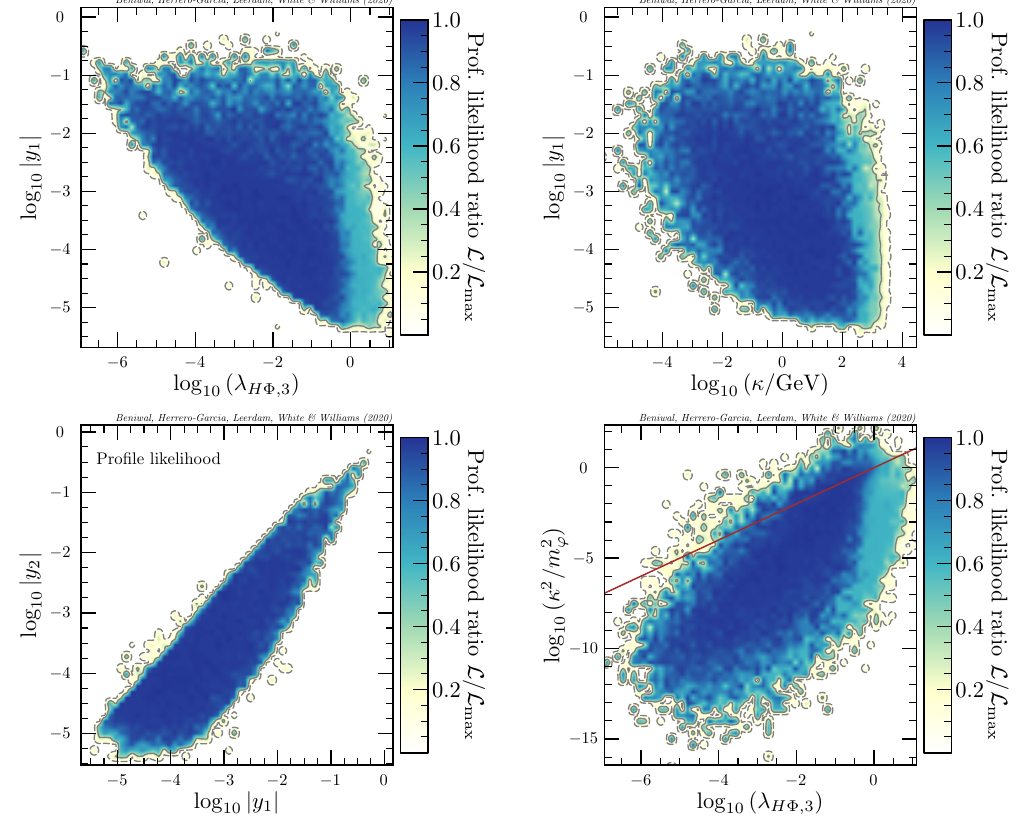
Figure 4 . 2D plots of PLR in the planes of model parameters for the case of η 2 DM. In the bottom- right plot, the solid brown line corresponds to a 1:1 relationship between κ 2 /m 2